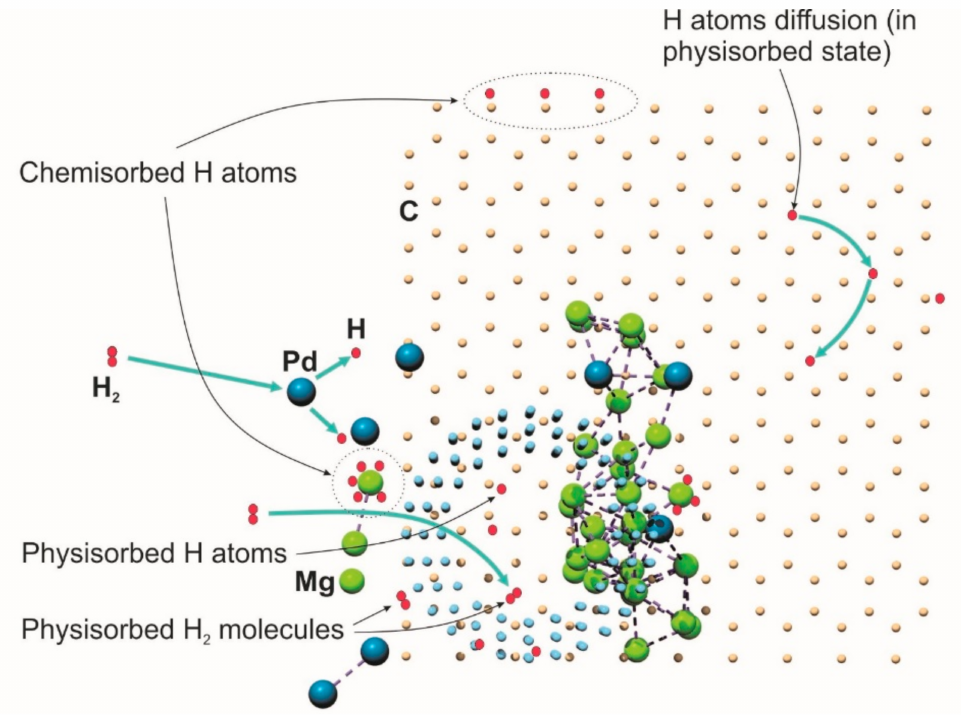
Figure 7. Schematic illustration of hydrogen absorption in G/f-MWCNT@PdMg